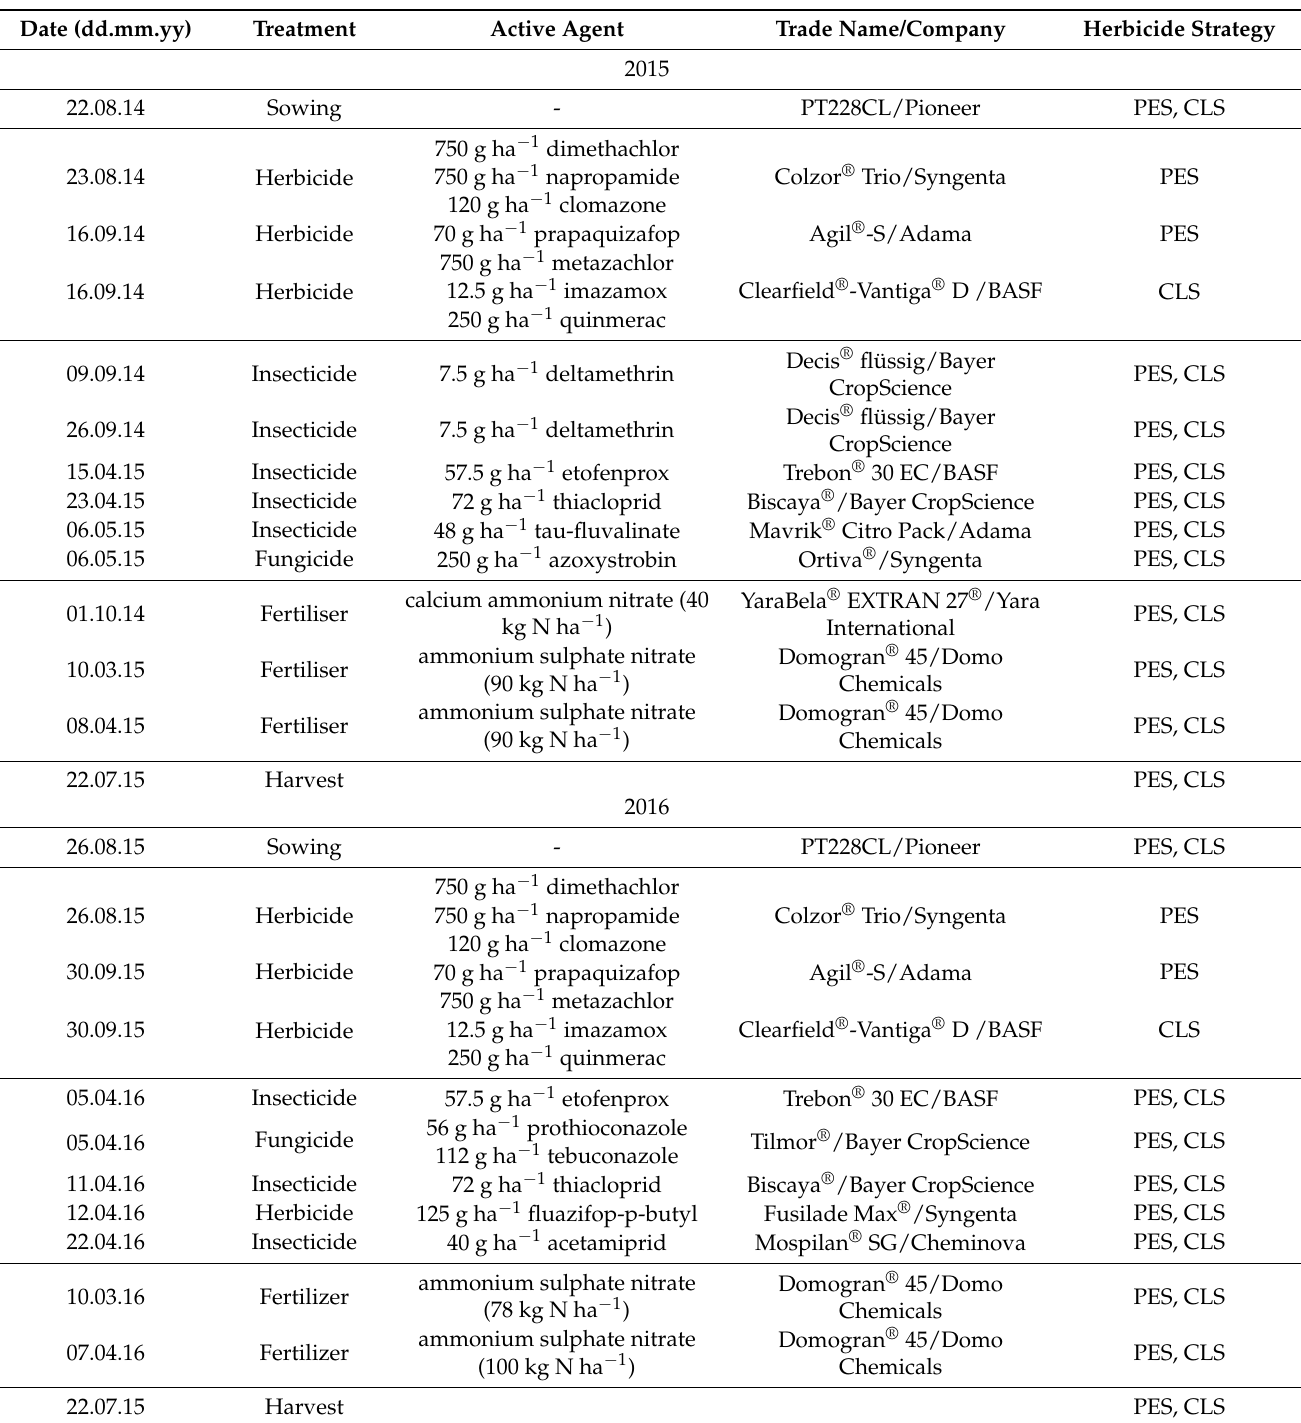
Table 1. Agronomic treatments during the Clearfield ® OSR management intensities experiment. Date